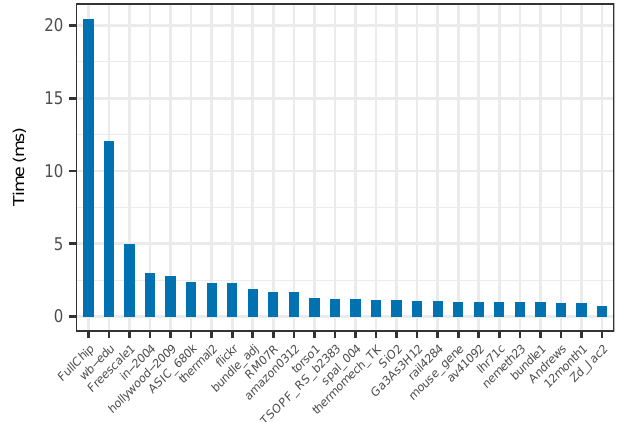
Figure 16. SURAA: Radix sort computation time on GPU for